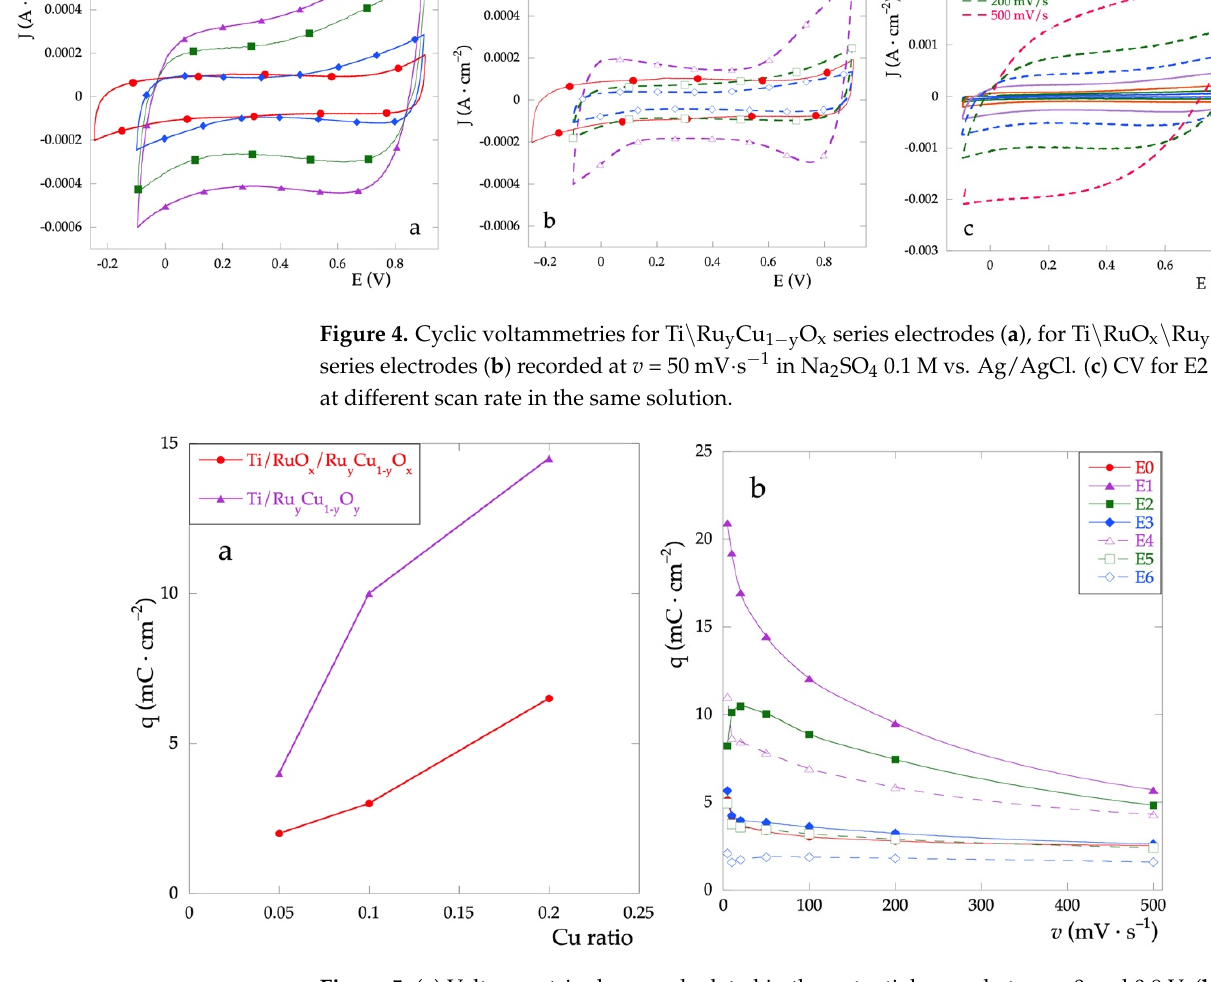
Figure 6. ( a ) CV curves recorded in Fe +2 /Fe +3 solution and v = 5 mV·s − 1 ; ( b ) dependence of J pa and J pc vs. v 1/2 at various scan rates; ( c ) log (J) vs. log ( v ) plot. Compared to the electrode E0, which exhibits the best performance, the addition of variable amounts of Cu only slightly affects the E 1/2 half-wave potential determined as (E pa + E pc )/2. As for the peak-to-peak separation ( Δ E p ), the presence of Cu generally causes an increase in the Δ E p value. Given that the value of Δ E p is related to the electron transfer kinetics, the identified trend indicates that the presence of Cu worsens the electron trans- fer reversibility. However, the performance of the electrodes containing the lowest Cu percentage is quite similar to that presented by the electrode containing only RuO x thus indicating that low Cu amounts do not impair electron transfer reversibility.